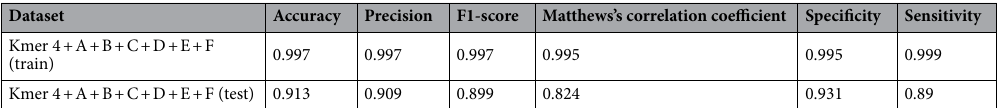
Table 5. The overall results of AptaNet after feature selection. Where Kmer 4 is 4mer frequency for aptamer properties. For protein properties: A indicates hydrophobicity, hydrophilicity, and mass; B indicates polarity, molecular weight, and melting point; C indicates transfer free energy, buriability, and bulkiness; D indicates solvation free energy, relative mutability, and residue volume; E indicates volume, amino acid distribution, and hydration number; F indicates isoelectric point, compressibility and chromatographic index.